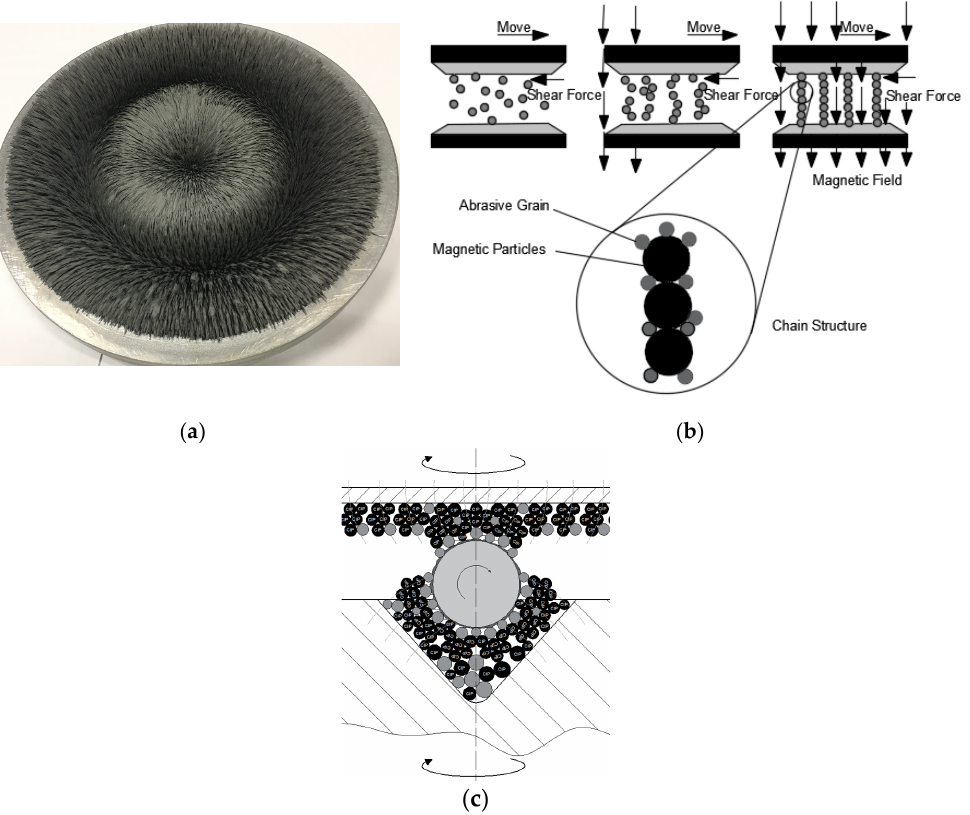
Figure 1. ( a ) the magnetorheological pad ( b ) The formation of the magnet chains ( c ) polishing mechanism of clustered magnetorheological finish (CMRF).